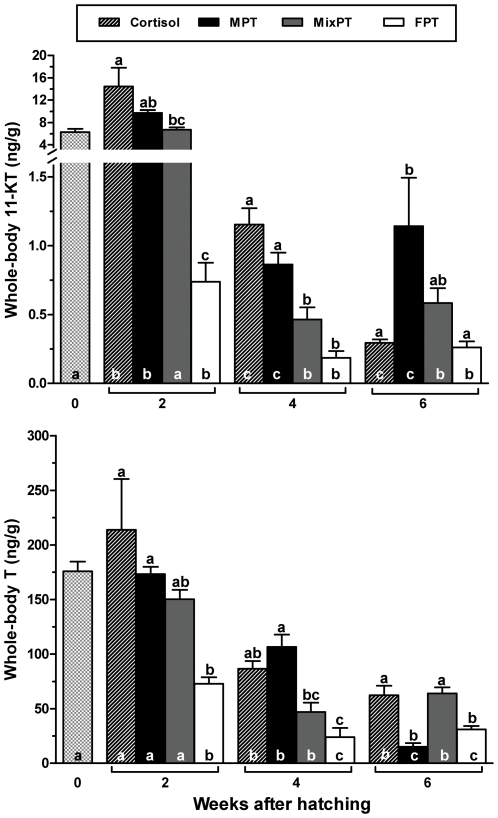
Concentrations of 11-ketotestosterone (11-KT) and testosterone (T) in cortisol-treated larvae reared at MixPT (24°C) and in untreated larvae reared at MPT (29°C), MixPT (24°C) and FPT (17°C) between 0 and 6 wah.Different letters inside and above the bars indicate statistically significant differences between weeks for the same temperature and between treatments on the same week, respectively (One-way ANOVA followed by the Tukey test; P≤0.05; GraphPad Prism v.4.00). Larvae fed cortisol showed higher titres of 11-KT than the corresponding control (MixPT) between 2 and 4 wah. Both 11-KT and T were significantly higher in the MPT compared to the FPT on the same weeks.